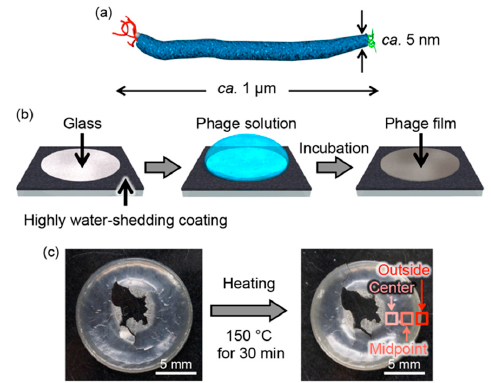
Figure 1. Schematic illustration of ( a ) M13 bacteriophage (M13 phage) and ( b ) preparation of the phage film. ( c ) Optical photographs of the as prepared (left) and the thermally treated (right) films composed of liquid crystalline oriented M13 phages.